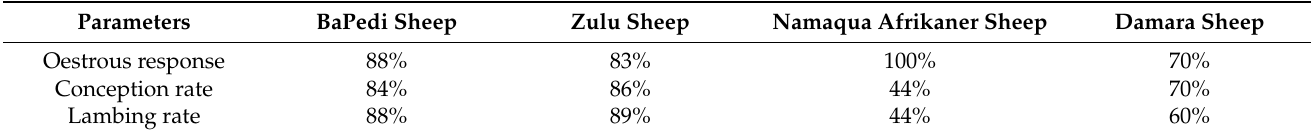
Table 7. Oestrous response and fertility of South African indigenous breeds [43].